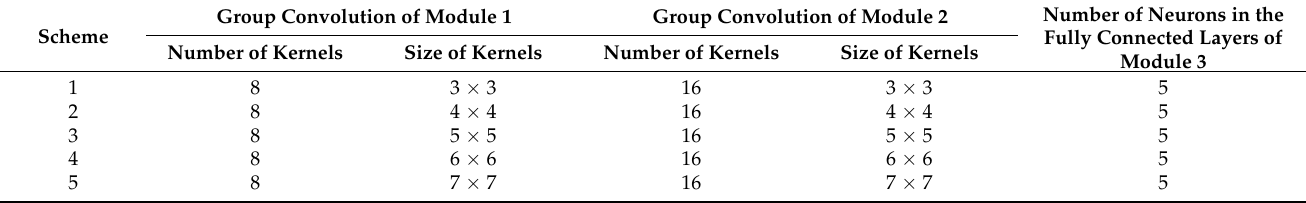
Table 5. Hyperparameter combination schemes with different sizes of convolution kernels 1 .